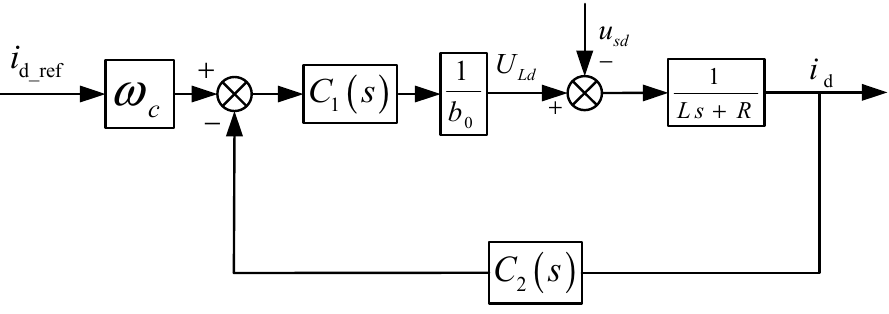
Figure 9. Improved LADRC-controlled D-STATCOM system structure.